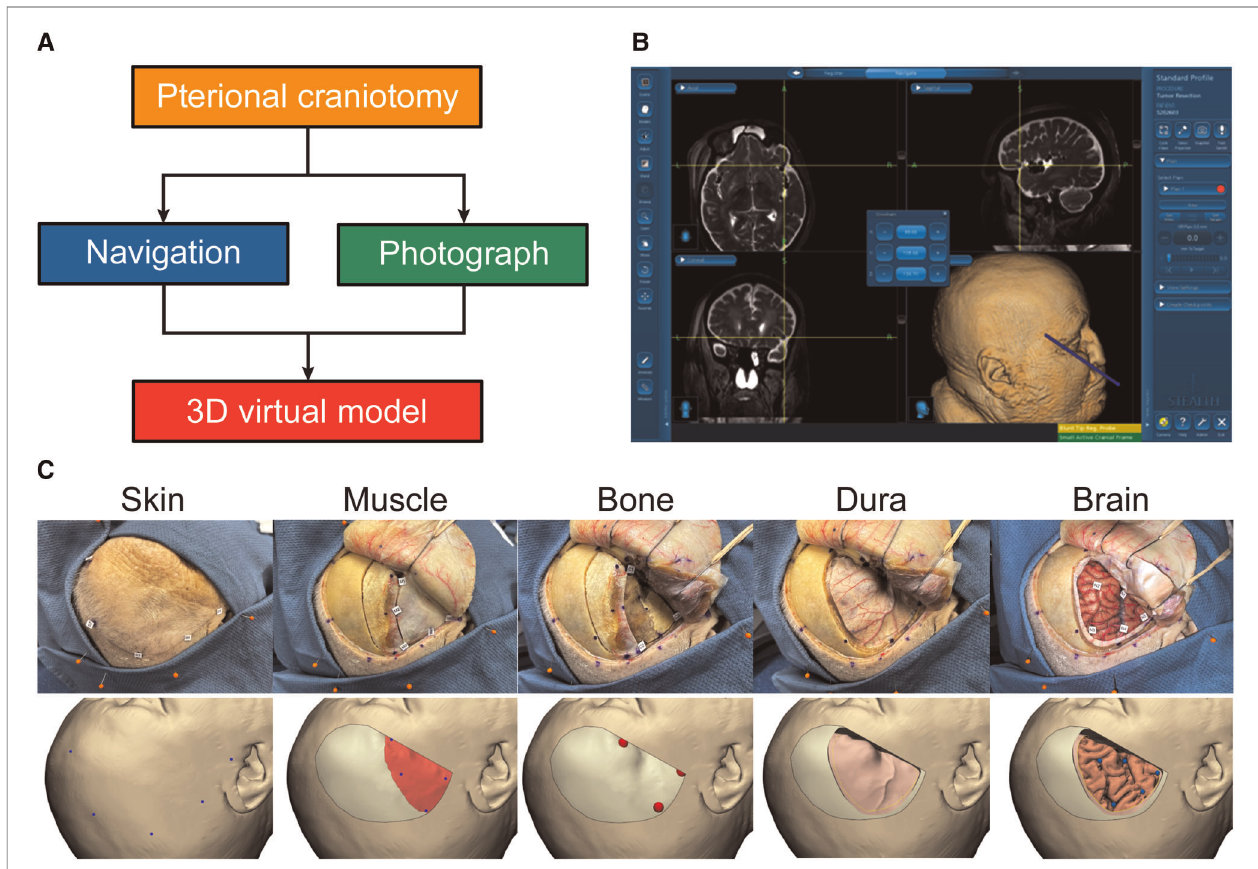
FIGURE 3 | Creation of virtual pterional craniotomy model. ( A ) Steps to create 3D pterional craniotomy model. ( B ) Synchronous data acquisition through neuronavigation. ( C ) Stepwise pterional craniotomy with images in the real-world setting (top panels) and 3D virtual model (bottom panels). Used with permission from Barrow Neurological Institute, Phoenix, Arizona